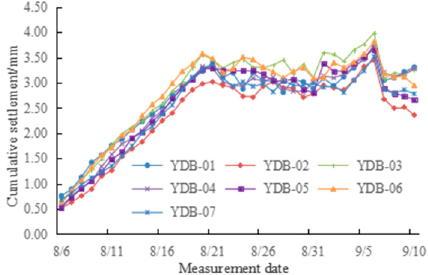
Figure 9. Relation between surface subsidence and time.